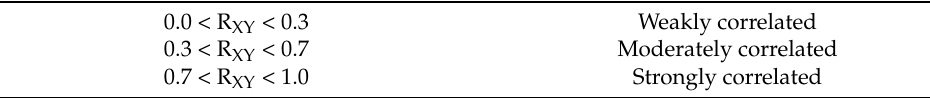
Figure 5. Autocorrelation results of B4: ( a ) lap time and ( b ) correlation coefficient. Table 4. Correlation magnitude interpretation